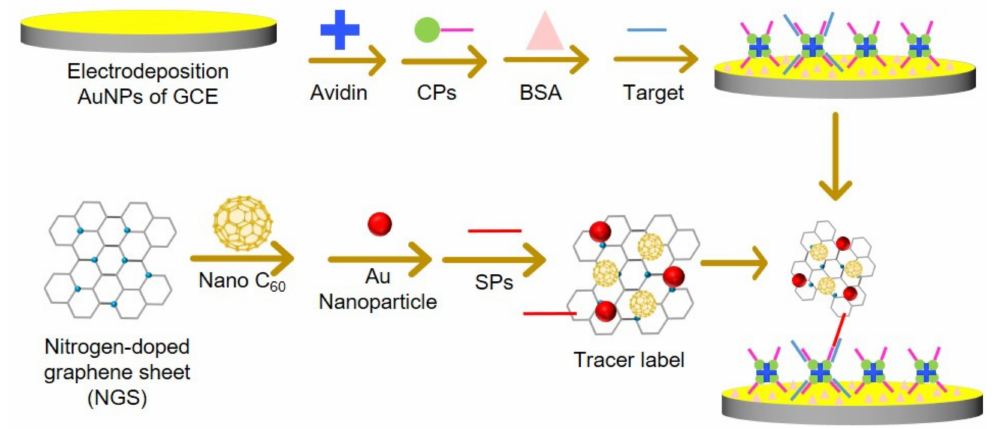
Figure 16. Schematic diagram of the synthesis of Au-nano C 60 /NGS-based electrochemical biosensor for amplifying the detection of target DNA: GCE, glassy carbon electrode; BSA, bovine serum albumin; CPs, GGTGAGGTCTAAAAA-biotin; Target, AGACCTCACCTATGTGTCGA; and SPs, SH-(CH 2 ) 6